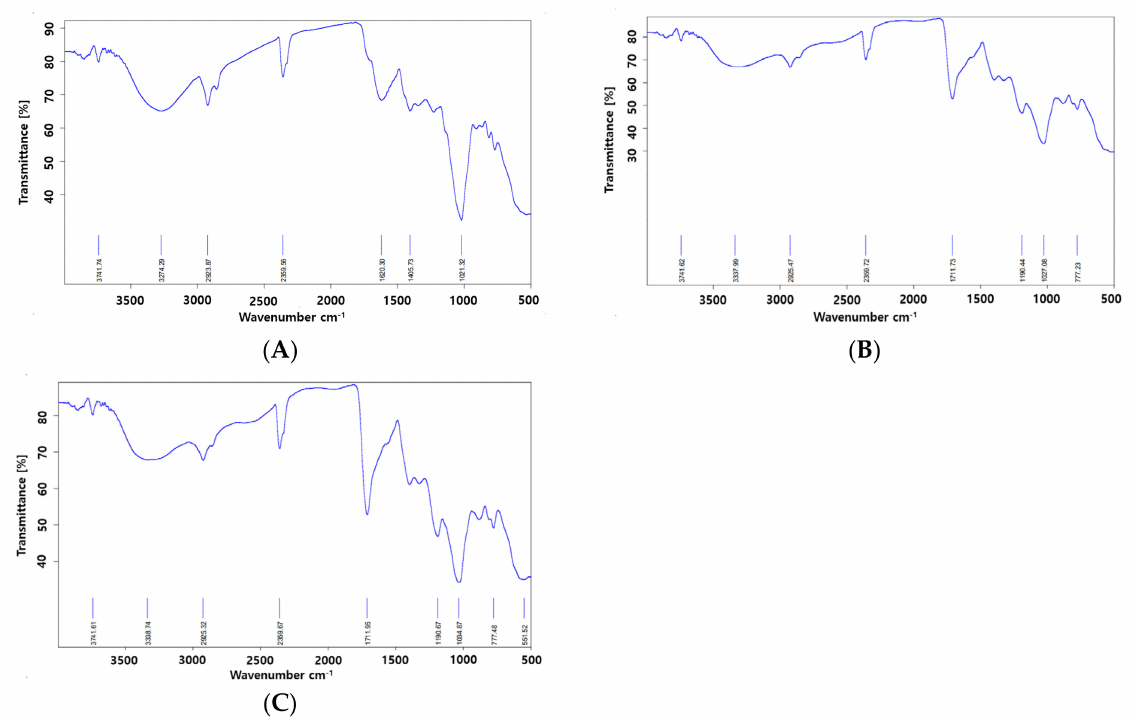
Figure 4. The FT-IR analysis of the MUL extrudate’s solid formulations, which were obtained by different chemical additives. ( A ); MUL powder (MUL), ( B ); solid formulations of the extrudate of MUL treated with 0.5 M citric acid (MUL- ESFs-CA), ( C ); solid formulations of the extrudate of MUL treated with citric acid 0.5 M and 0.3% sodium alginate 0.3%